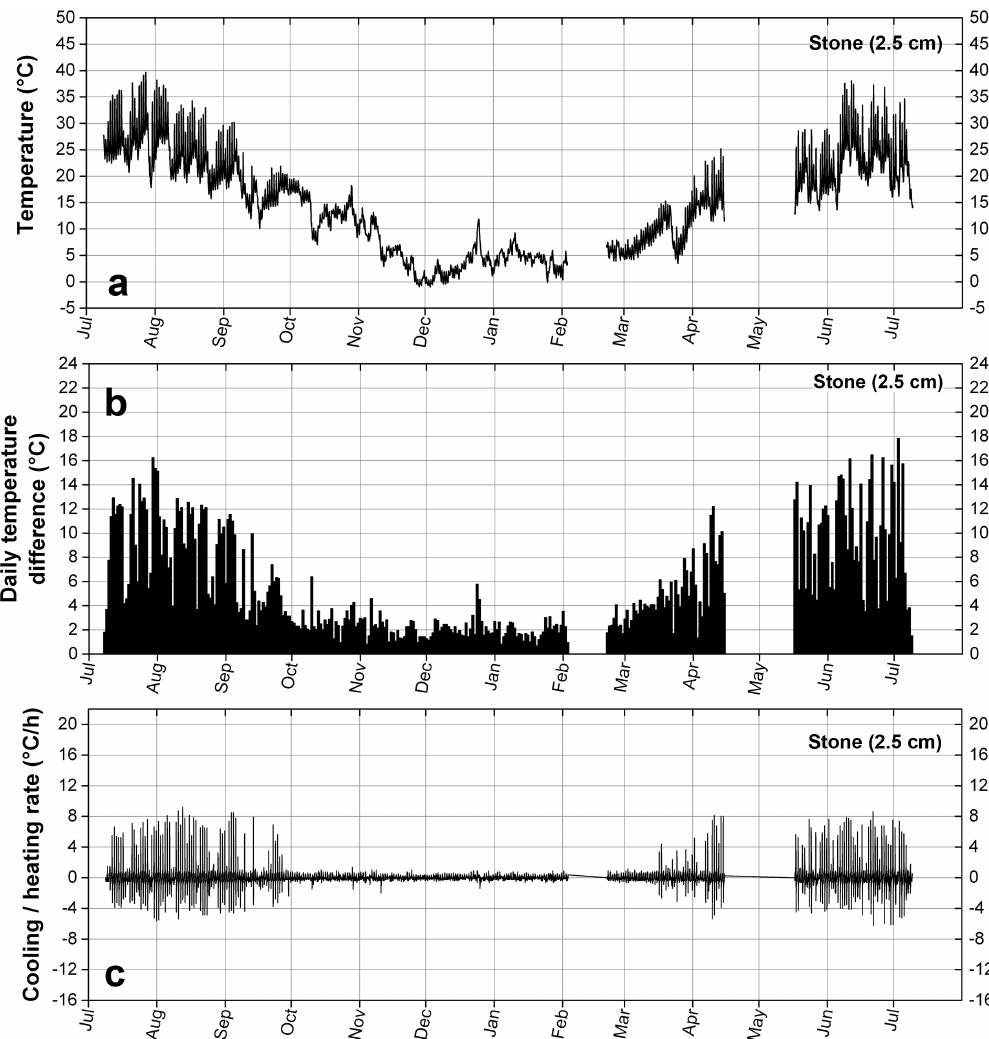
Figure 12. Temperature data measured in Notre-Dame de Vevey in the stone, below the interface with the repair layer, at a depth of 2.5 cm. ( a ) Temperature profile; ( b ) Temperature amplitude (daily temperature difference); ( c ) Rate of temperature